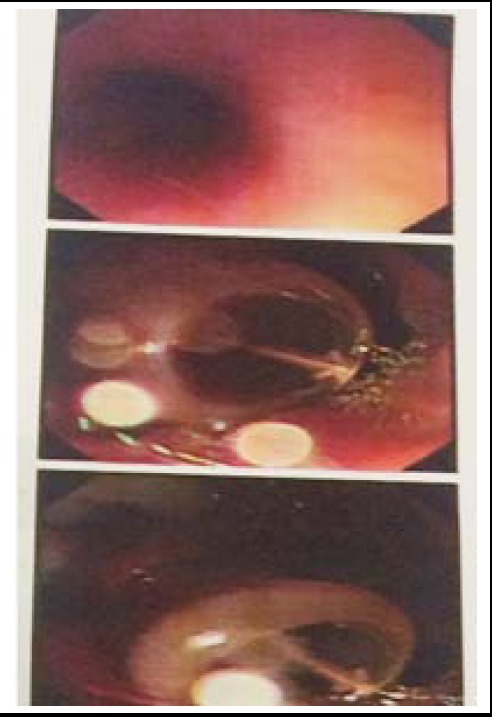
Endoscopy picture.